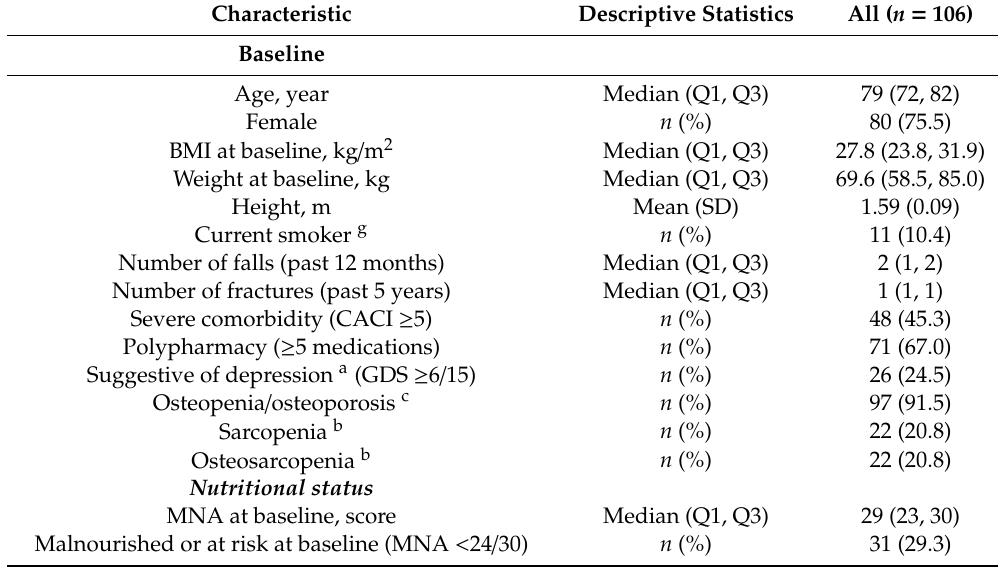
Table 1. Descriptive characteristics of the study sample, including change in nutritional